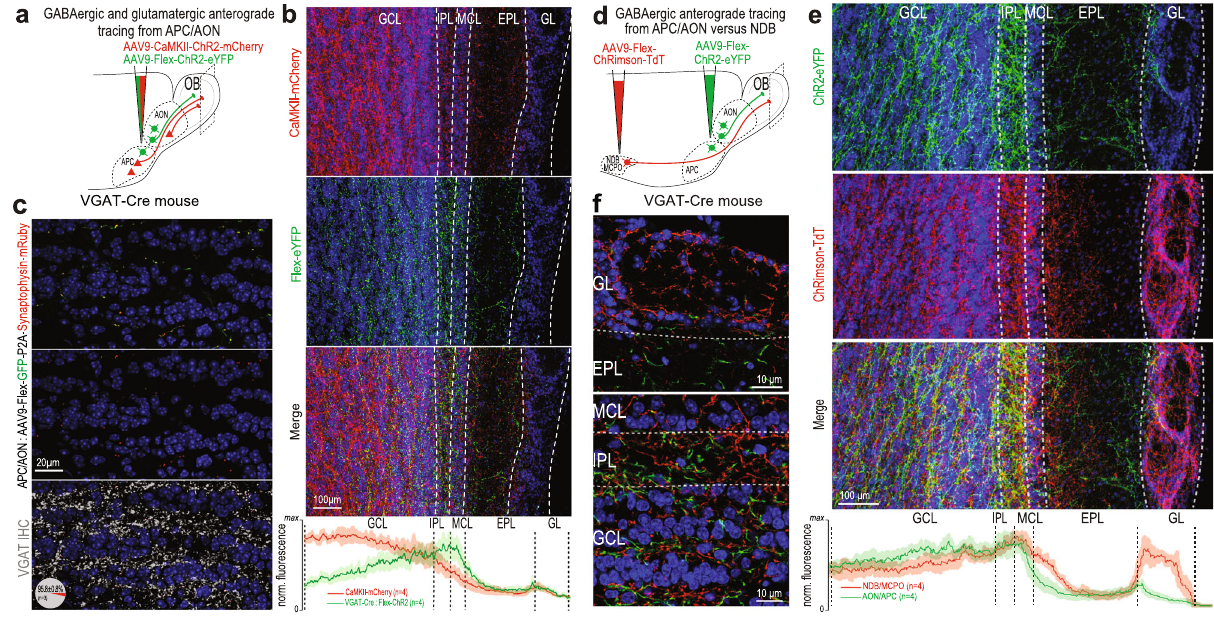
Fig.1|TheolfactorycortexsendsGABAergicprojectionsbacktotheOB.a Viral strategy for comparative anterograde labeling of glutamatergic (CaMKII-ChR2- mCherry)andGABAergic(Flex-ChR2-eYFP)axonsintheOBfromtheAON/APCina VGAT-Cremice. b Confocalimagesexhibitingthelaminarpro fi leofOBinnervation byglutamatergic(top,red)orGABAergic(middle,green)axonsfromtheAON/APC. Bottom, merge. Bottom plot, normalized fl uorescence intensity from glutamater- gic (red) versus GABAergic (green) axons across OB layers. Mean (solid line)±sem (shaded). n =4 mice. c High magni fi cation of the GCL of VGAT-Cre mice injected with AAV9-Flex-GFP-P2A-Synaptophysin-mRuby in the AON/APC. Top, GABAergic axon shafts (green) and their presynaptic mRuby-positive boutons (red). Middle, Synaptophysin-mRubychannelonly.Bottom,immunohistochemistry(IHC)against VGATis overlayed with theSynaptophysin-mRubysignal. 98±0.8% ofthe putative